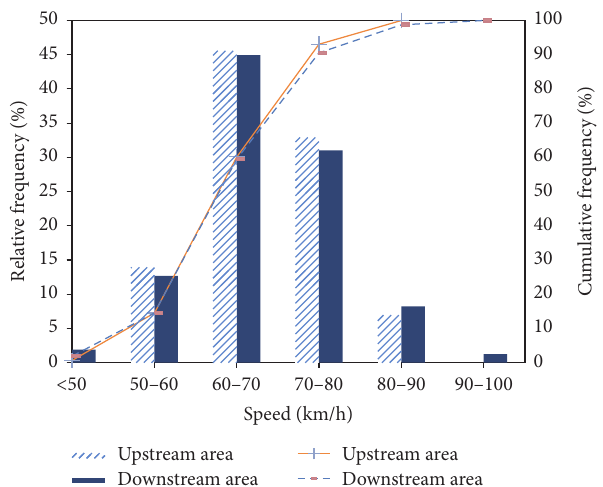
Figure 7: Relative and cumulative frequency distribution of speed in the status of not transmitting any